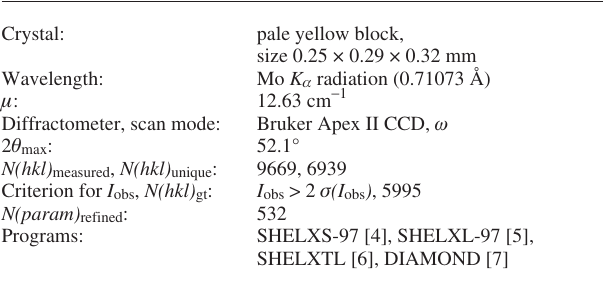
Table 1. Data collection and handling.